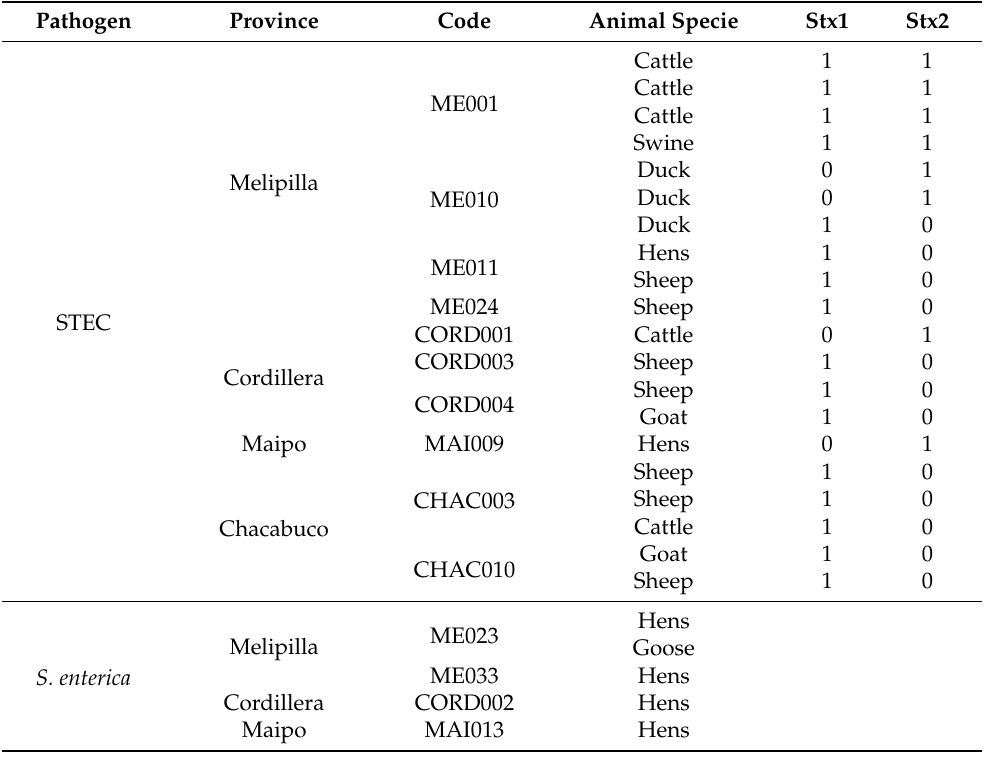
Table 5. Positive samples for STEC and S. enterica by province, BPS, animal species and Stx type.